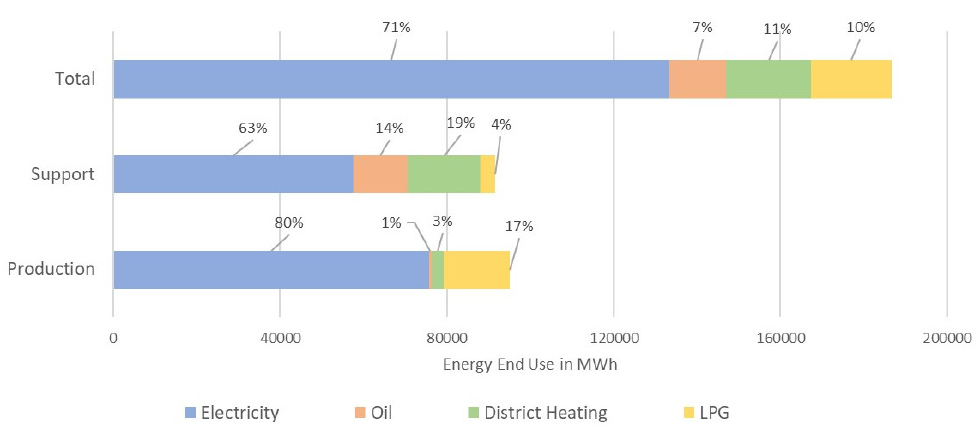
Figure 8. The share of energy end-use (EEU) from different energy carriers for the Swedish engineering industry based on case study. Percentage in order of electricity, oil, district heating (DH), and liquid petroleum gas (LPG).